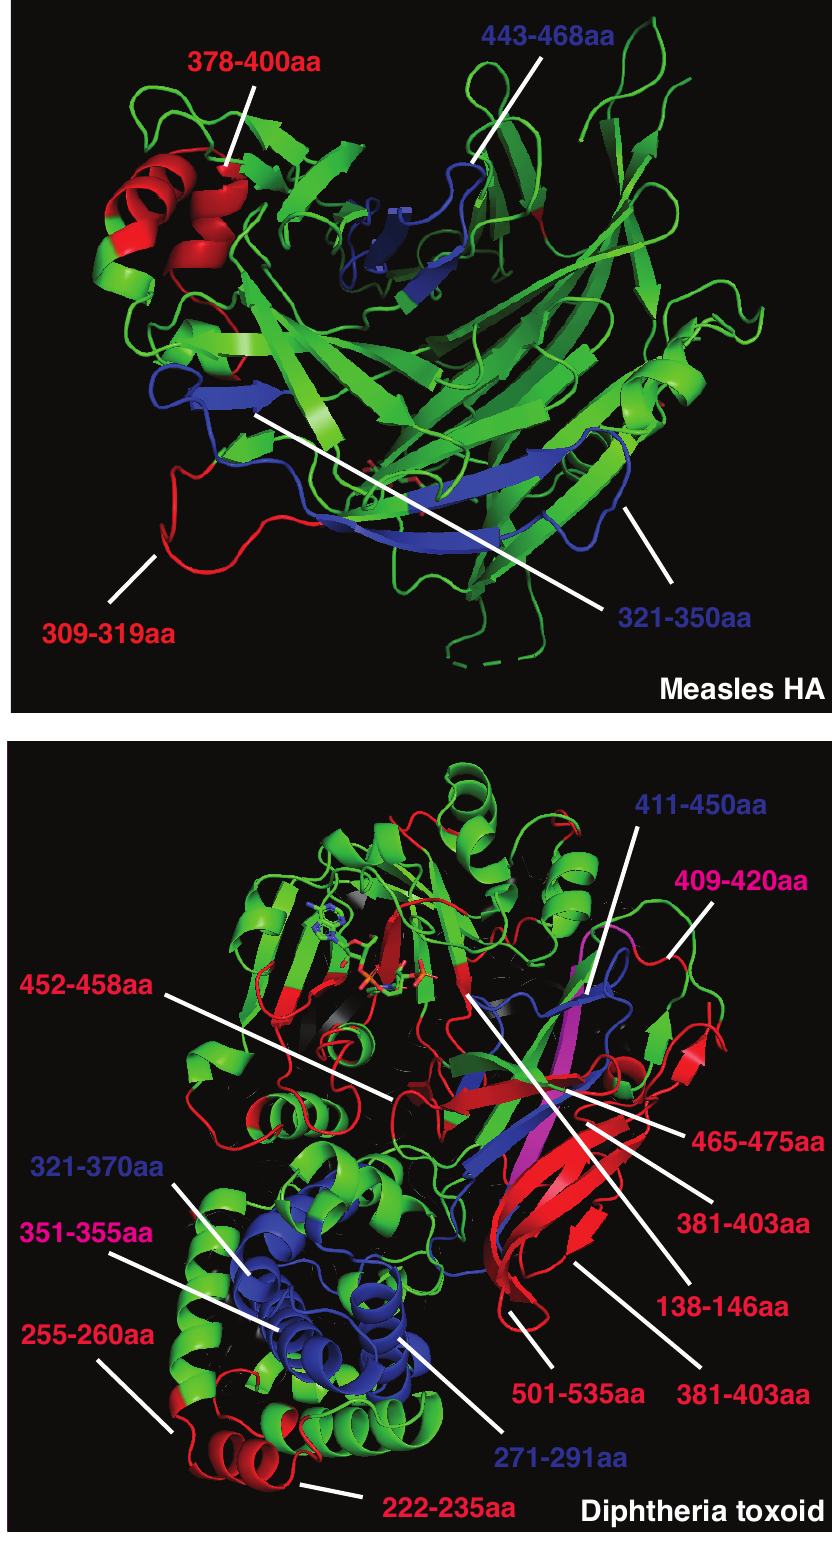
Figure 1. Crystal structure of measles hemagglutinin (PDB:2ZB6, top) or diphtheria toxoid (PDB:1MDT, bottom). Immunodominant B cell epitopes are depicted in red, while dominant CD4 determinants are highlighted in blue. Overlapping epitopes are highlighted in